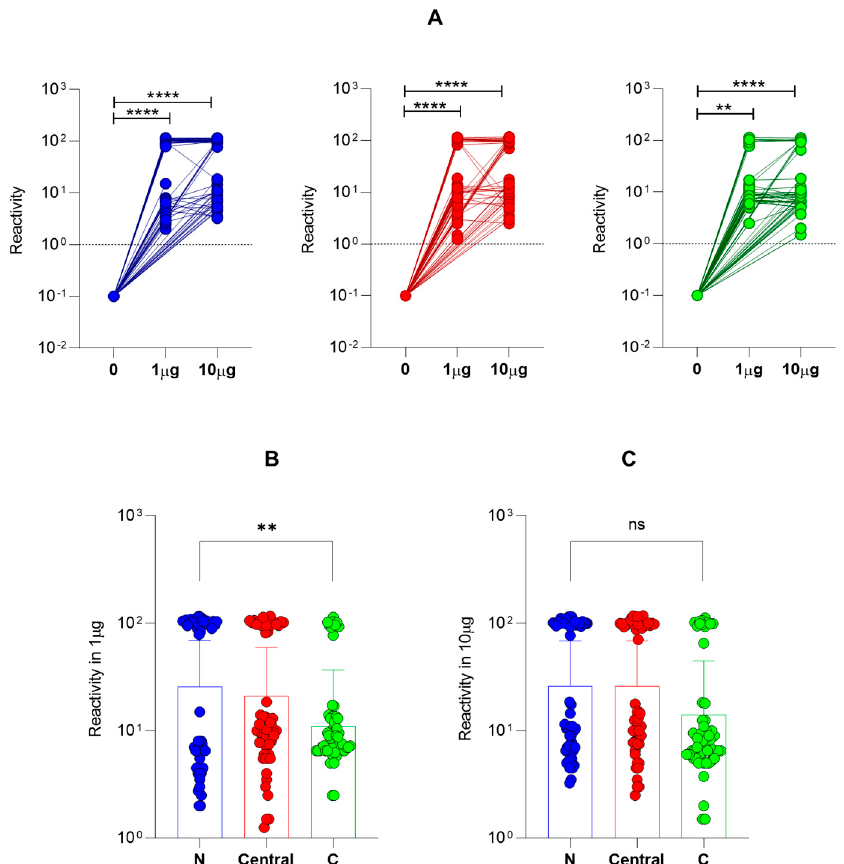
Figure 2. Dose-dependent binding of Tax peptides. Dose-dependence evaluation of HLA-A*02:01 haplotype-reactive Tax peptides distributed in the N-terminal, Central and C-terminal regions of the Tax protein. ( A ) Assessment of the reactivity of Tax peptides to HLA-A*02:01 using 0, 1 and 10 µg/mL distributed in the N-terminal, Central and C-terminal regions. ( B ) Scatter-plot representation of peptides reactive to HLA-A*02:01 at a concentration of 1 µg/mL distributed among the three regions of Tax: N-terminal, Central and C-terminal. ( C ) Scatter-plot representation of peptides reactive to HLA-A*02:01 at a concentration of 10 µg/mL distributed among the three regions of Tax: N-terminal, Central and C-terminal. Two asterisks (**) indicate p ≤ 0.01 and four asterisks (****) indicate p ≤ 0.0001.